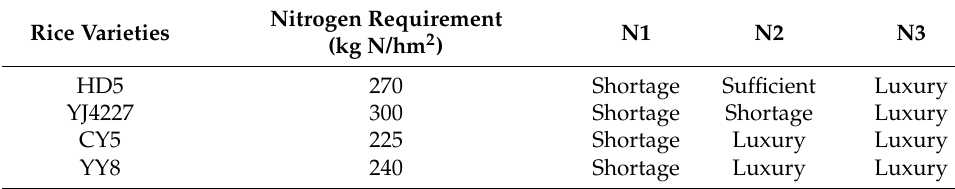
Table 2. The commentary on N1,2,3.